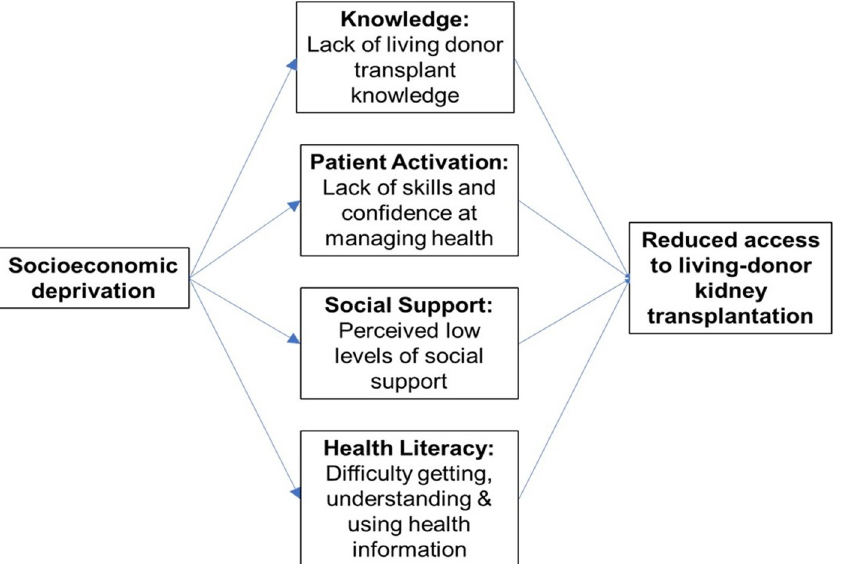
Fig 2. Mediators of socioeconomic inequity in living-donor kidney